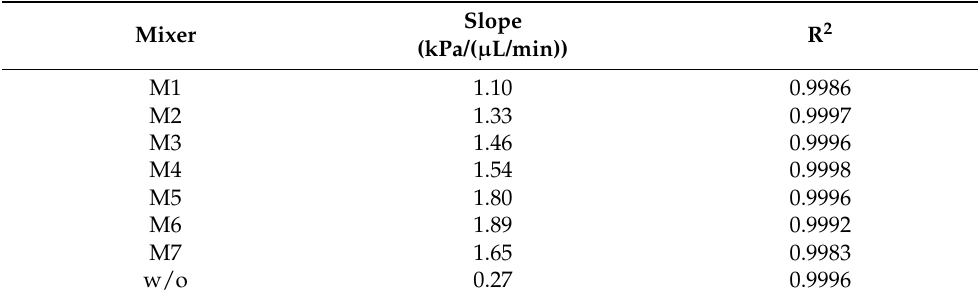
Figure 11. Experimental results showing the pressure drops of six different types of asymmetric micromixers (M1–M6) as a function of the flow rate in the range of 1 to 100 µL/min ( Re = 0.13–13). For comparison, the data obtained in a rectangular microchannel without mixing units and a serpentine micromixer (M7) are included in the graph. Table 3. Relationship between pressure drop in the micromixers and flow rate in the range of 1 to 100 µ L/min ( Re = 0.13–13). The slope of the linear regression line passing through the origin and the coefficient of determination (R 2 ) are